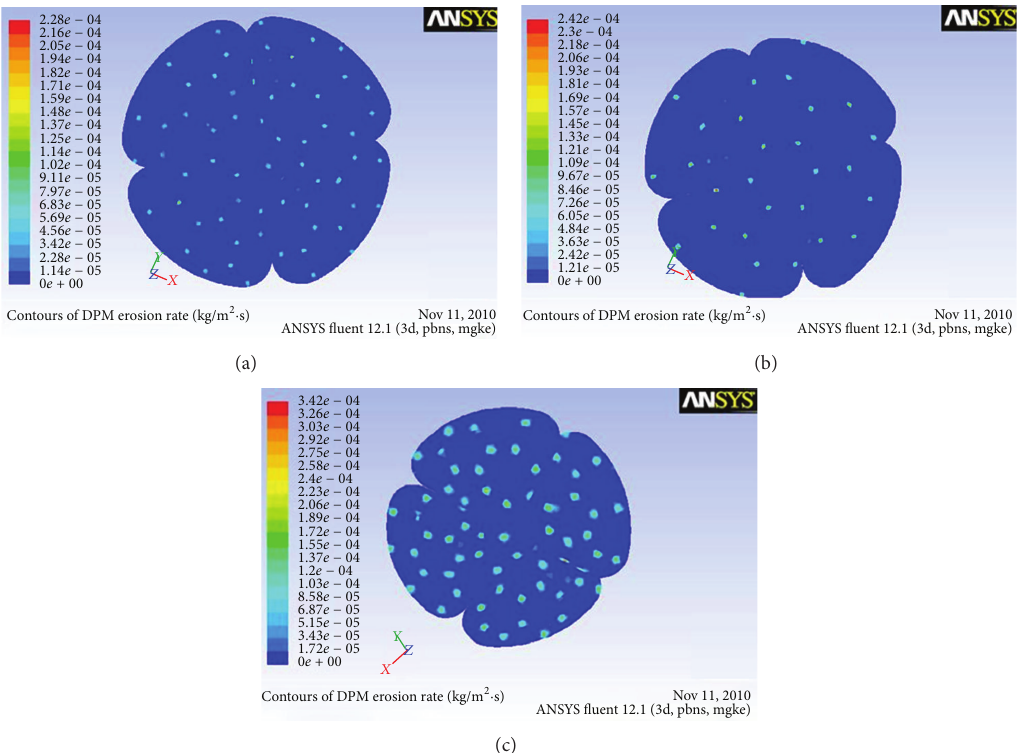
Figure 3: Numerical simulation results of the erosion rate of three kinds of blades: (a) groove surface morphology; (b) convex surface morphology; (c) smooth surface.